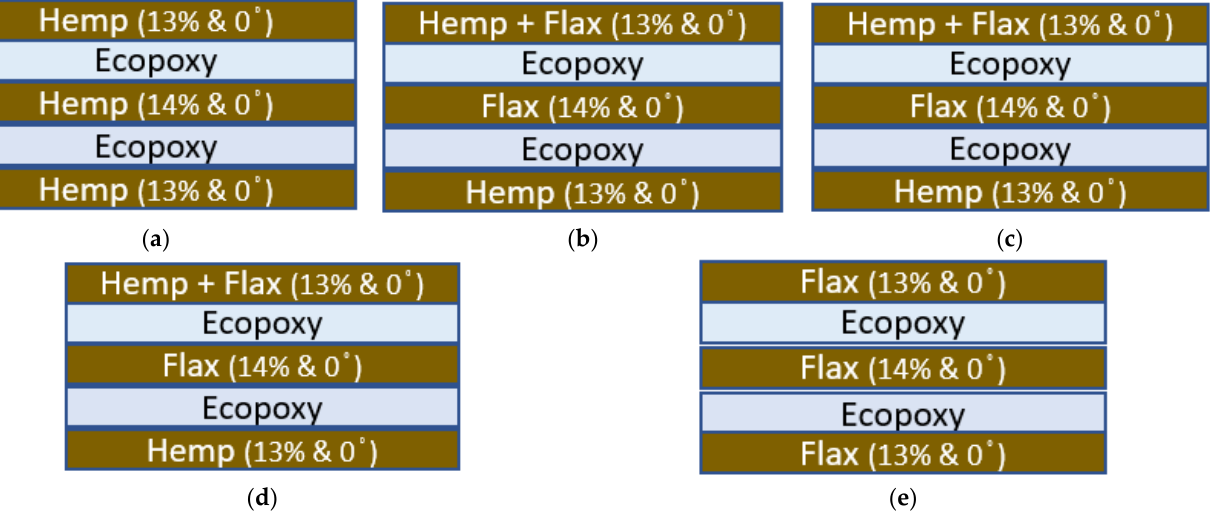
Figure 1. Schematic layout of the ply sequence for ecopoxy-matrix-based hybrid composites. ( a )